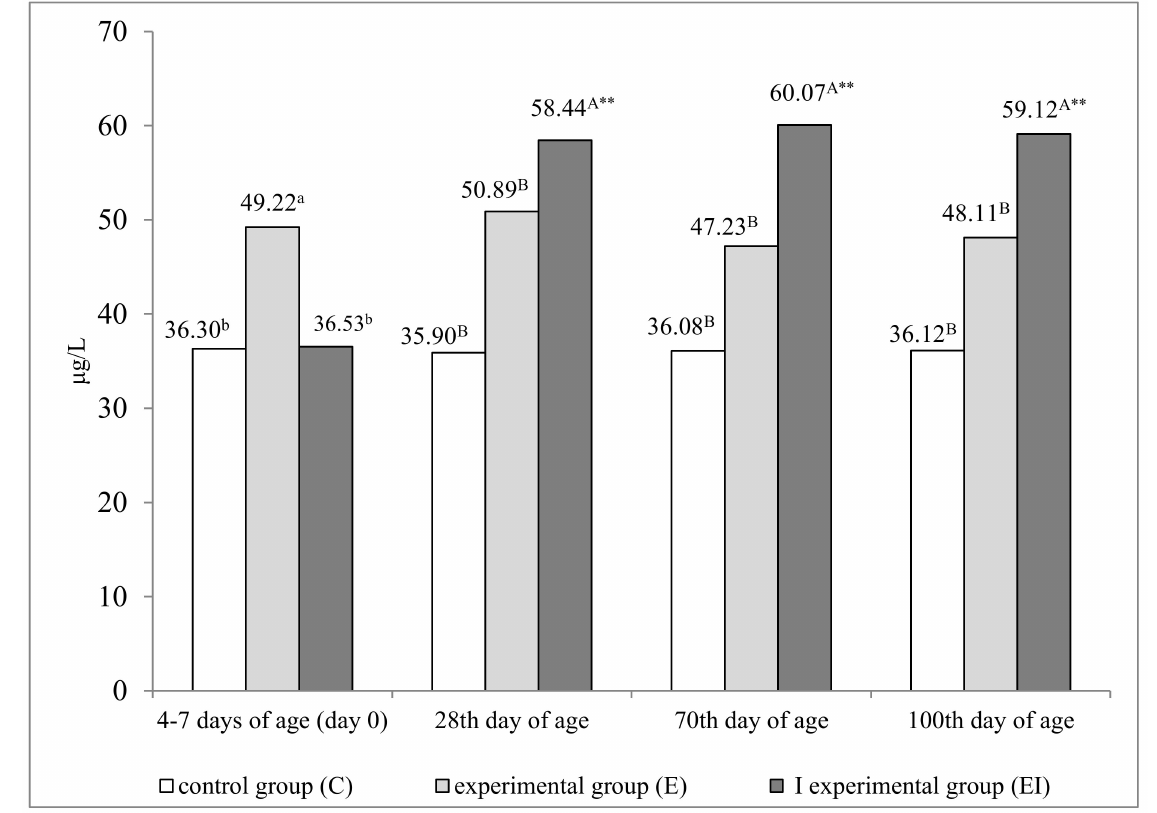
Figure 2. Serum selenium concentration in lambs from control group C, experimental group E, and I experimental group EI ( µ g/L). a, b— p ≤ 0.05; A, B— p ≤ 0.01. ** p ≤ 0.01—significant difference relative to day